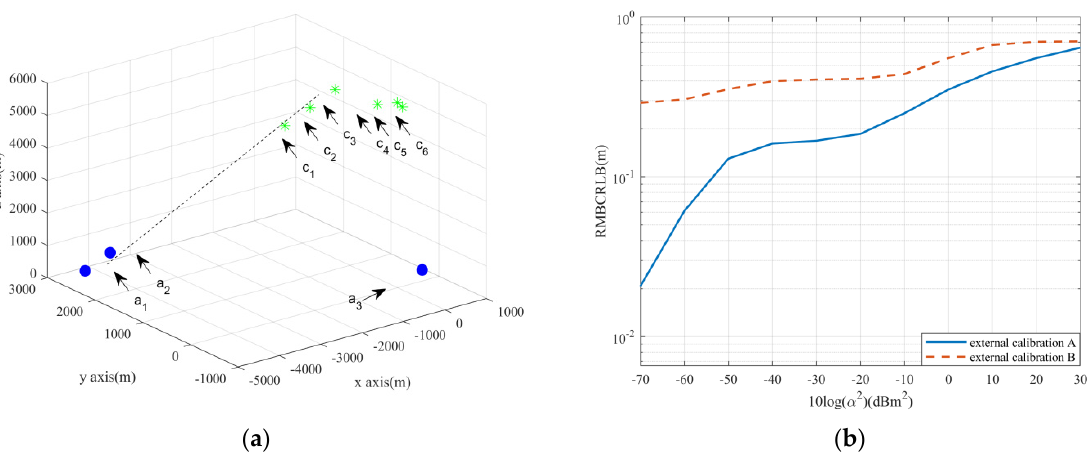
Figure 7. The RMBCRLBs for configuration calibration versus 10log( α 2 ) with/without the presence of internal measurements when σ 2 = 0.5 m 2 . ( a ) The arrangement of the distributed sensor network assisted by three noncollinear auxiliary sources. ( b ) The RMBCRLBs versus 10log( α 2 ) with/without the presence of internal measurements.